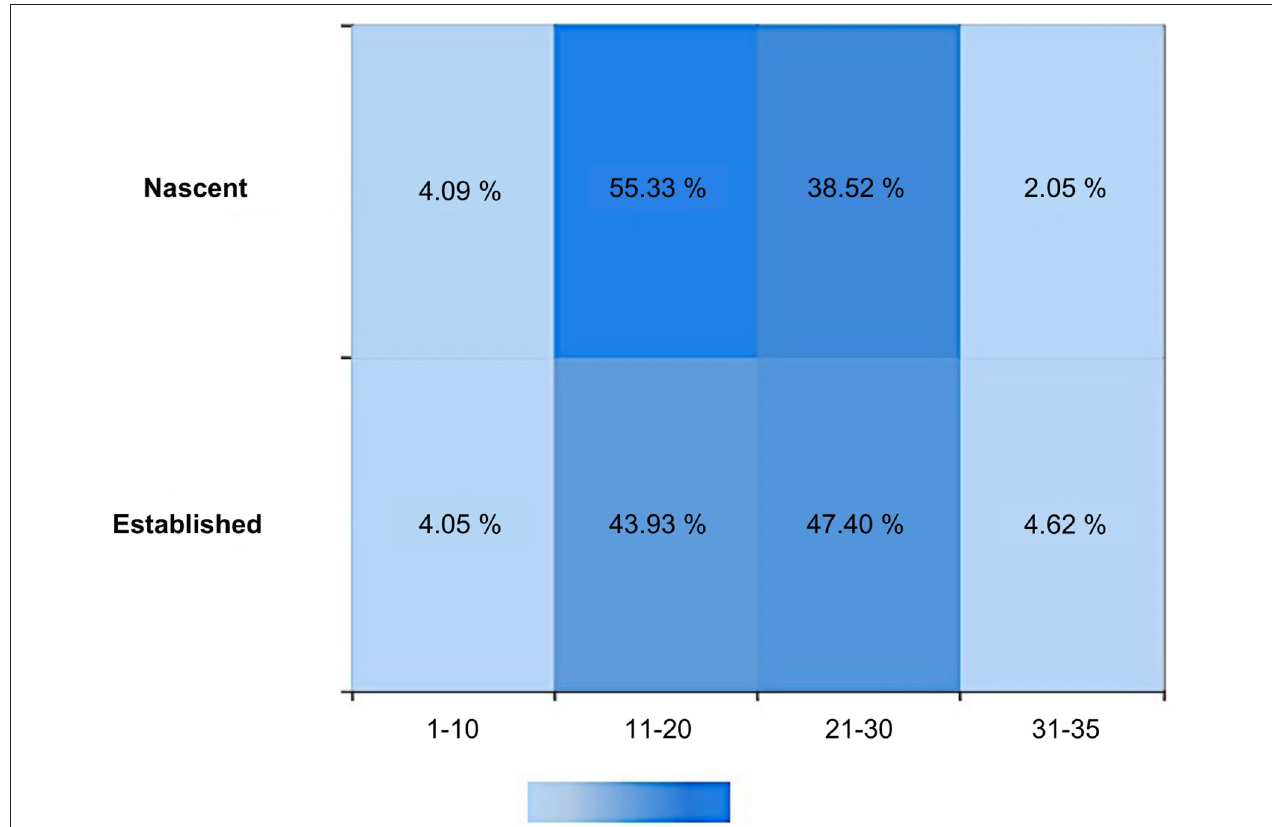
FIGURE 2 | Wellbeing score distribution of established and nascent